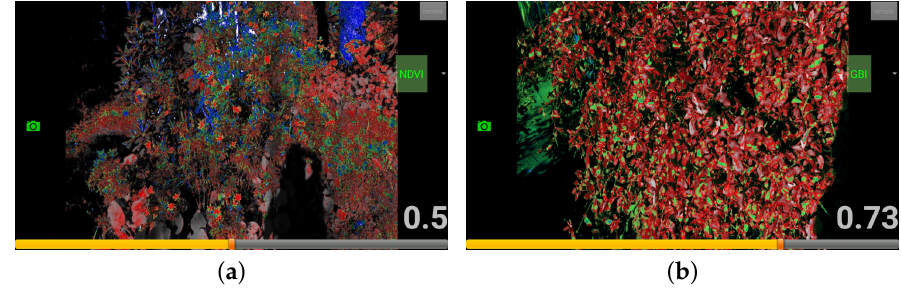
Figure 8. ImScope: ( a ) Normalized difference vegetation index (NDVI) image processing result; ( b ) GBI image processing result.